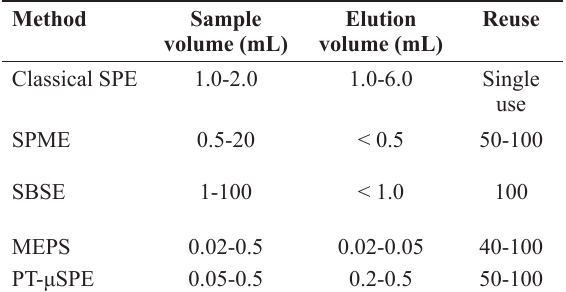
Some characteristics of sample preparation techniques. Adapted from Kabir et al. 2017 and Mahdi-Moein et al.